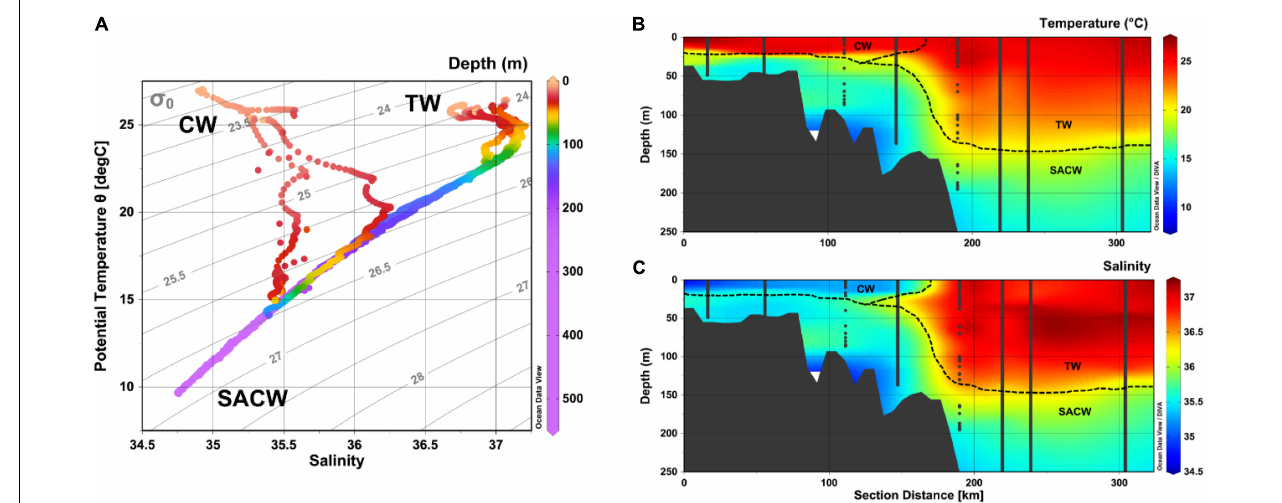
FIGURE 2 | (A) Temperature-Salinity-Depth diagram (0–500 m) depicting the water masses observed within the sampled region (TW, Tropical Water; CW, Coastal Water; SACW, South Atlantic Central Water) with gray lines indicating the isopycnals. Vertical distribution (0–200 m) of (B) temperature and (C) salinity showing the spatial distribution of the identified water masses. Produced with Ocean Data View (Schlitzer, 2016).